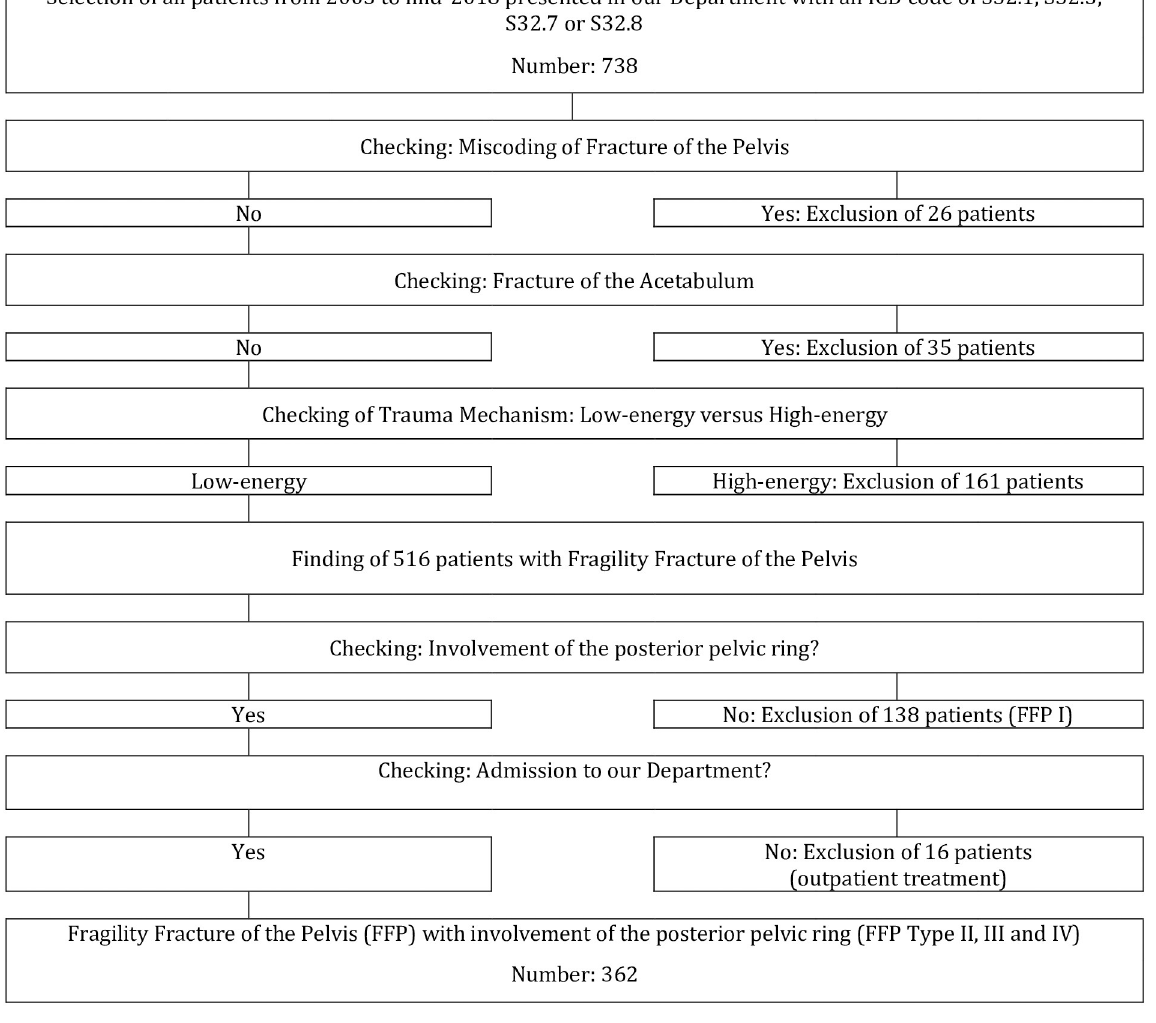
Fig 2. Flowchart of excluded and included study